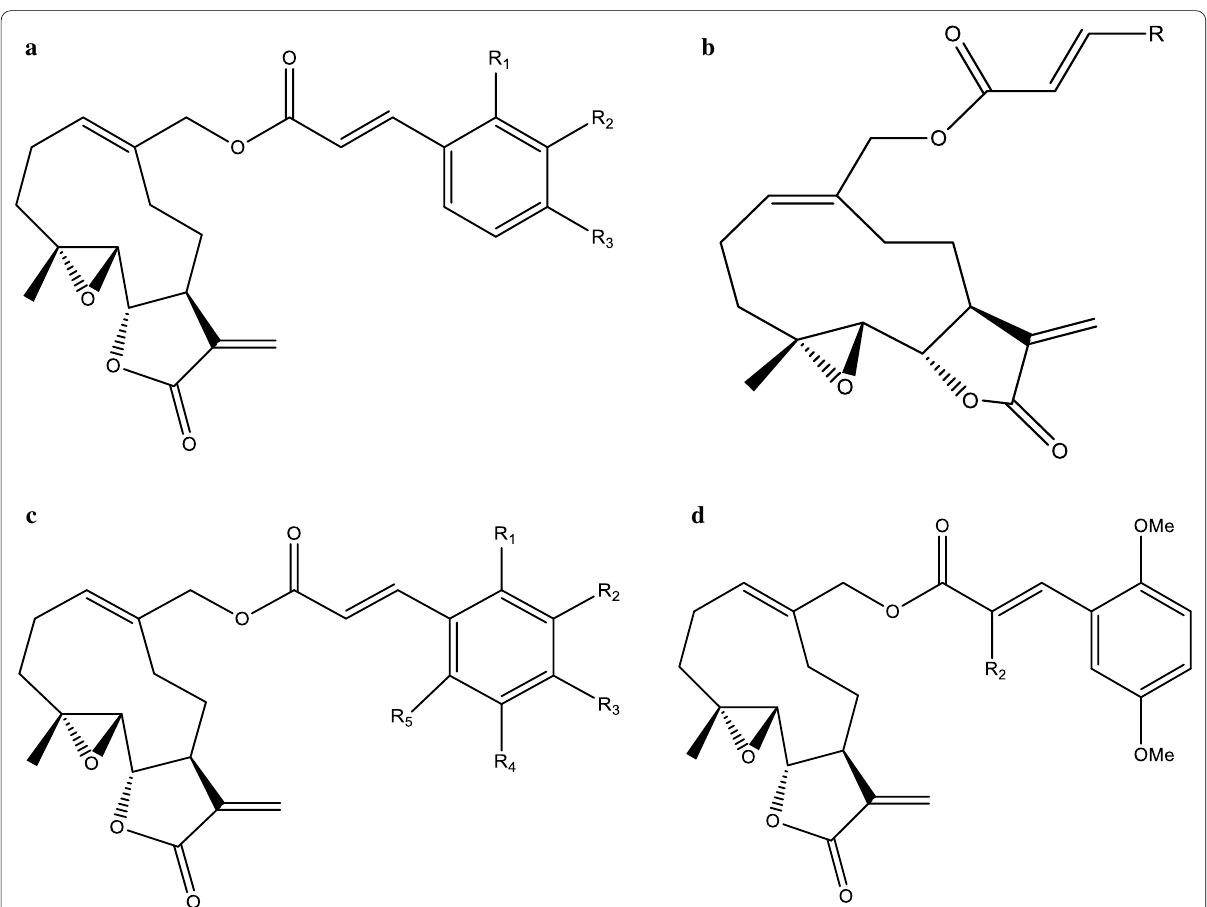
Table 3. d Parthenolide template molecule 4 for Table